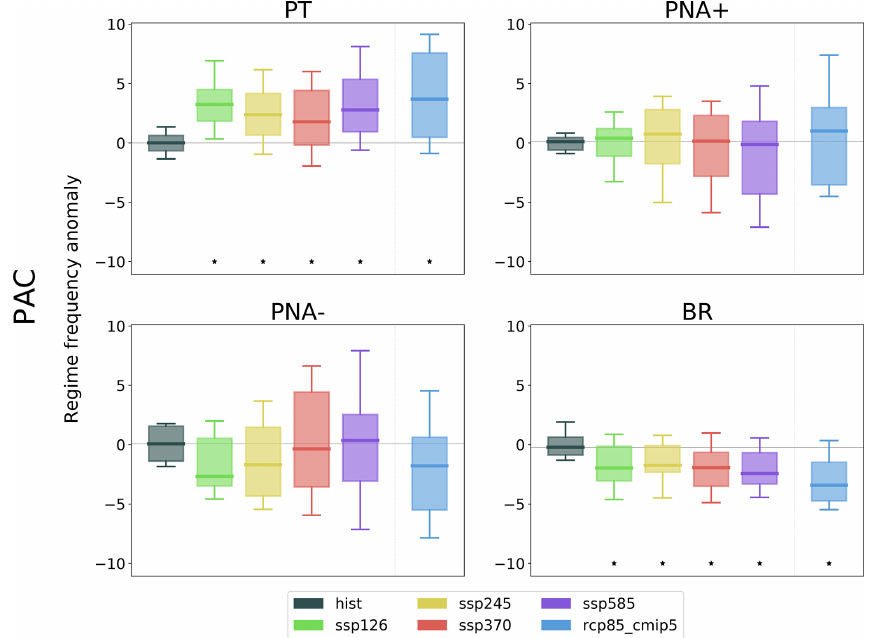
Figure 6. Same as Fig. 4 but for PAC